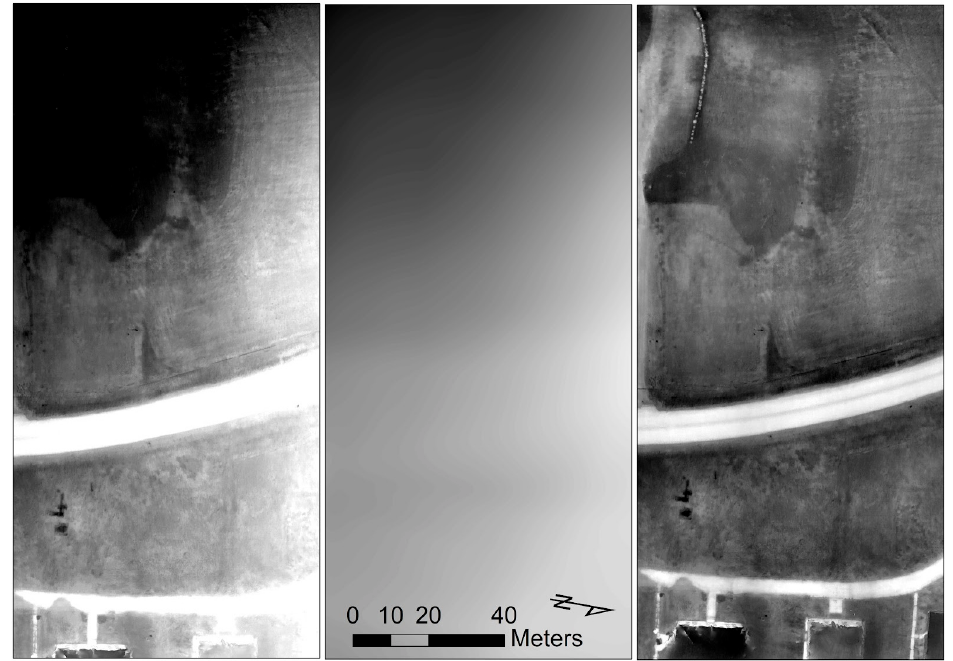
Figure 3. ( left ) Raw data showing significant thermal drift from top to bottom (recorded 12:20 a.m. 12 May 2017 at 60 m). ( center ) Low pass filter showing the major drift trend. ( right ) Result of subtracting the low pass filter from the original data.